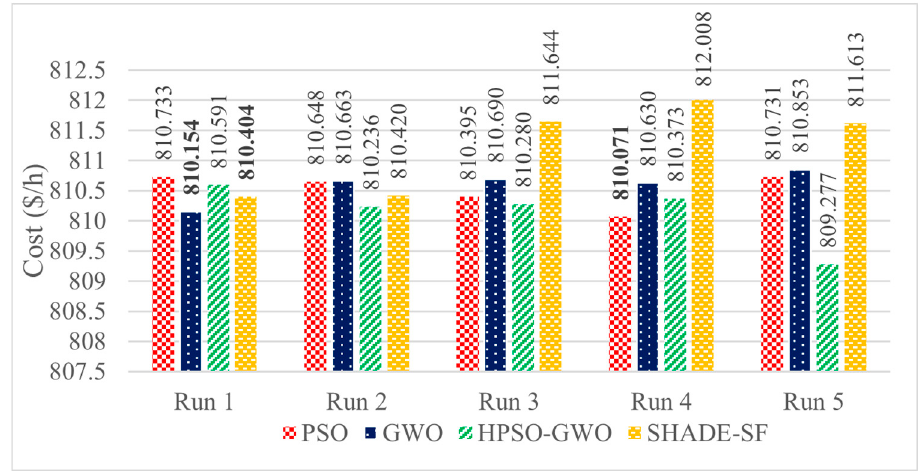
Figure 30. Cost comparison of 5 runs (Case 5). Table 7. Simulation results for Case 5.